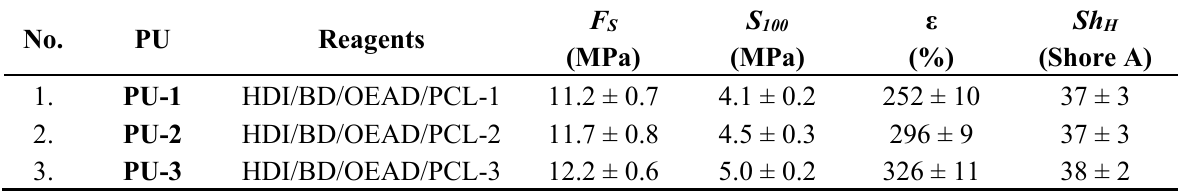
Table 5. Properties of the synthesized polyurethanes after the biodegradation process.